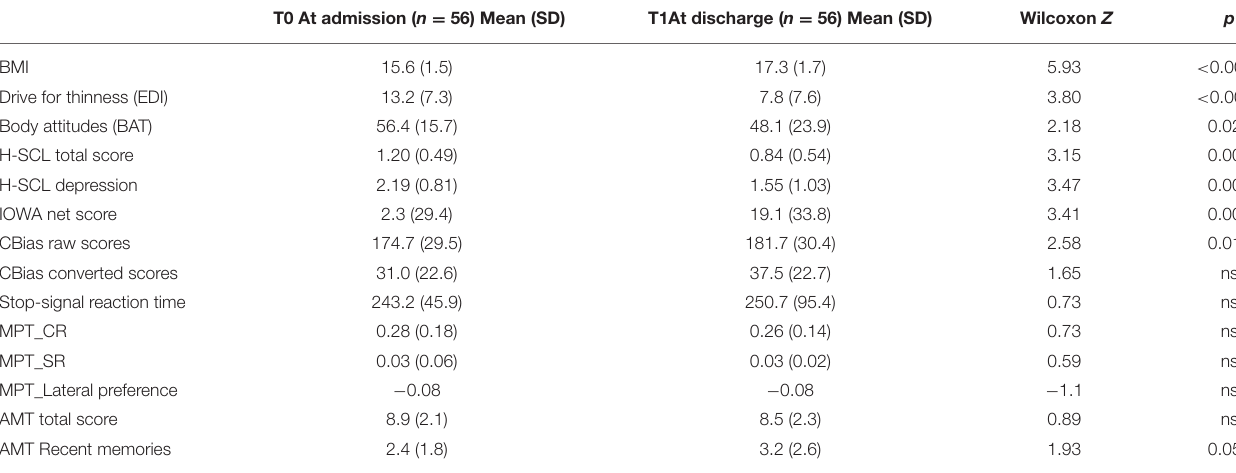
TABLE 4 | Clinical and psychopathological variables across two longitudinal assessment time